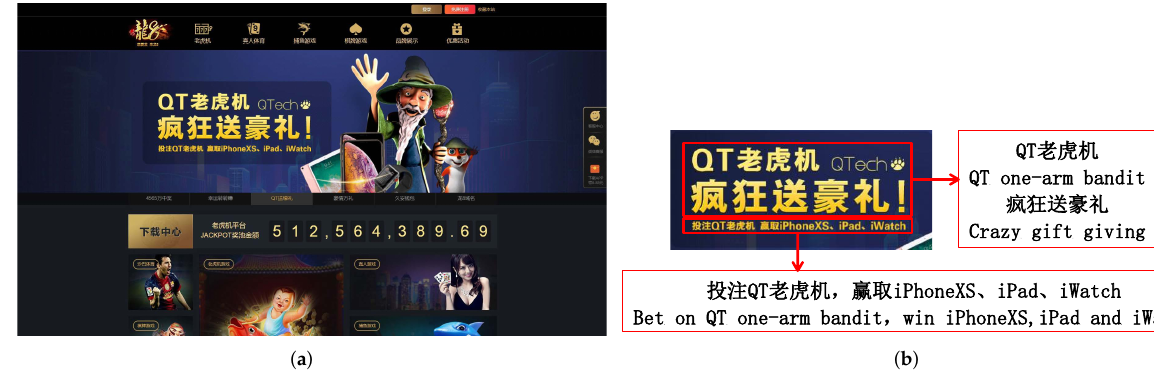
Figure 1. A webpage screenshot of a gambling website. ( a ) The webpage screenshot. ( b ) The text content in the